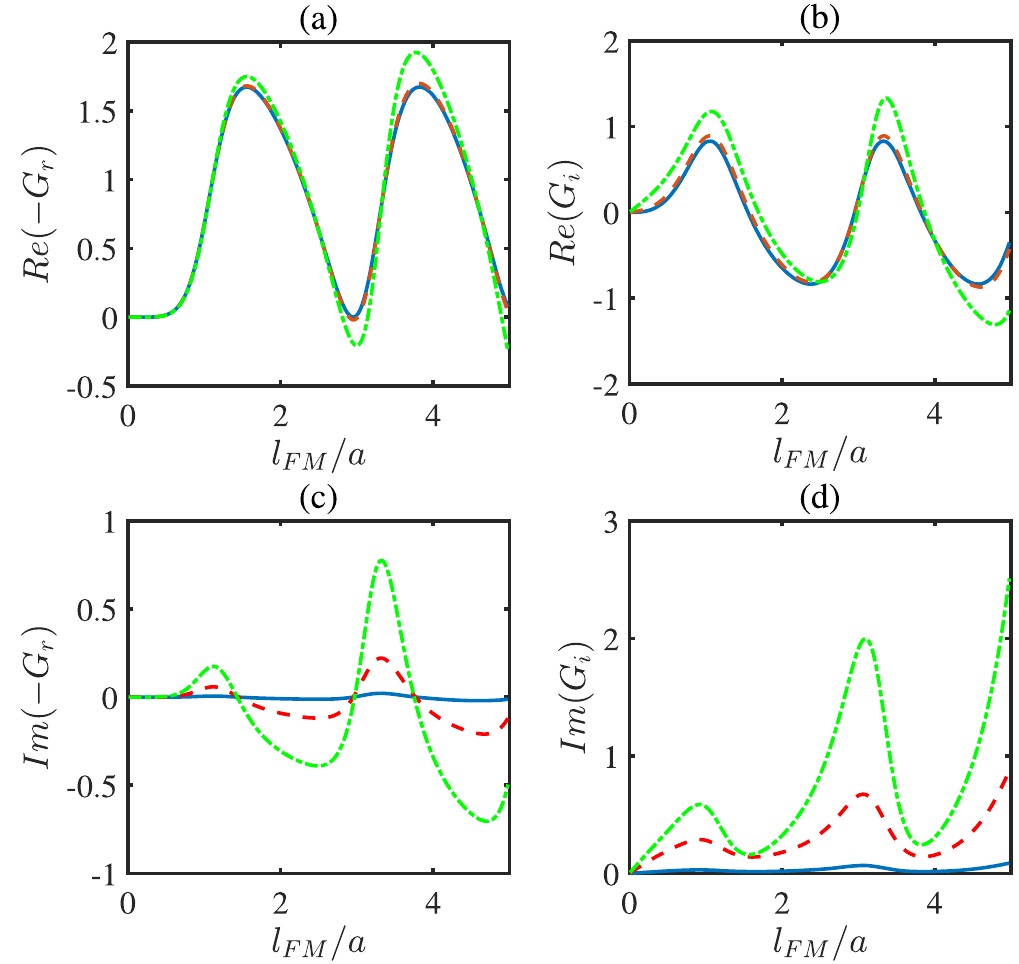
Figure 7. The numerical results for the real and imaginary parts of G r , i versus the FMM layer thickness l FM with different γ / E . γ / E = 0.01 for the solid line, γ / E = 0.1 for the dashed line, and γ / E = 0.3 for the dotted line. The other parameters chosen are θ = 0.3 π , − gS / E = 1.2, and μ 0 / E = 0.01. The units of G r , i is e 2 / ħa 2